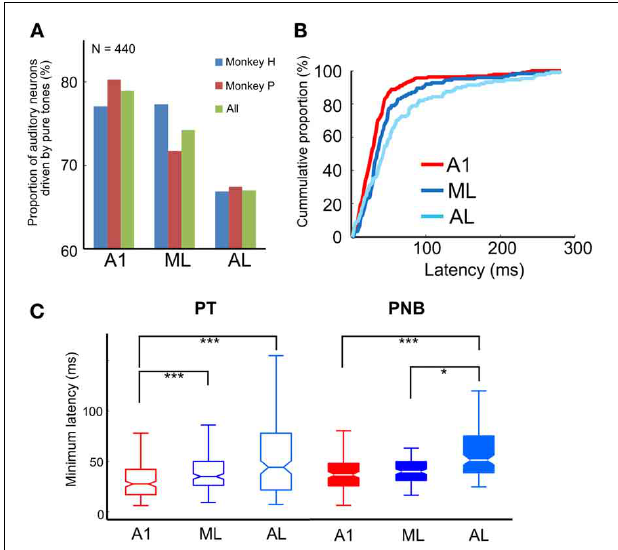
FIGURE 3 | (A) Proportion of auditory neurons driven by pure tones in A1, ML, and AL. The proportion was greatest in A1, followed by ML and AL. (B) Cumulative proportion of minimum response latency to pure tones. Latencies in LB (i.e., ML and AL) were significantly longer than in A1 [median: A1: 28ms, N = 188; ML: 35ms, N = 124; AL: 44ms, N = 128; A1 vs. ML, p < 0 . 001; A1 vs. AL, p < 0 . 001 (Tukey’s HSD test)]. (C) Minimum response latency to pure tones (PT) (left) and pink-noise bursts (PNB) (right) across the three subdivisions of auditory cortex. The central marks of the boxplots show the median latency between the 25th and 75th percentiles. The asterisks denote the significance level of post-hoc testing (Tukey’s HSD test, ∗ p < 0 . 05, ∗∗∗ p < 0 .